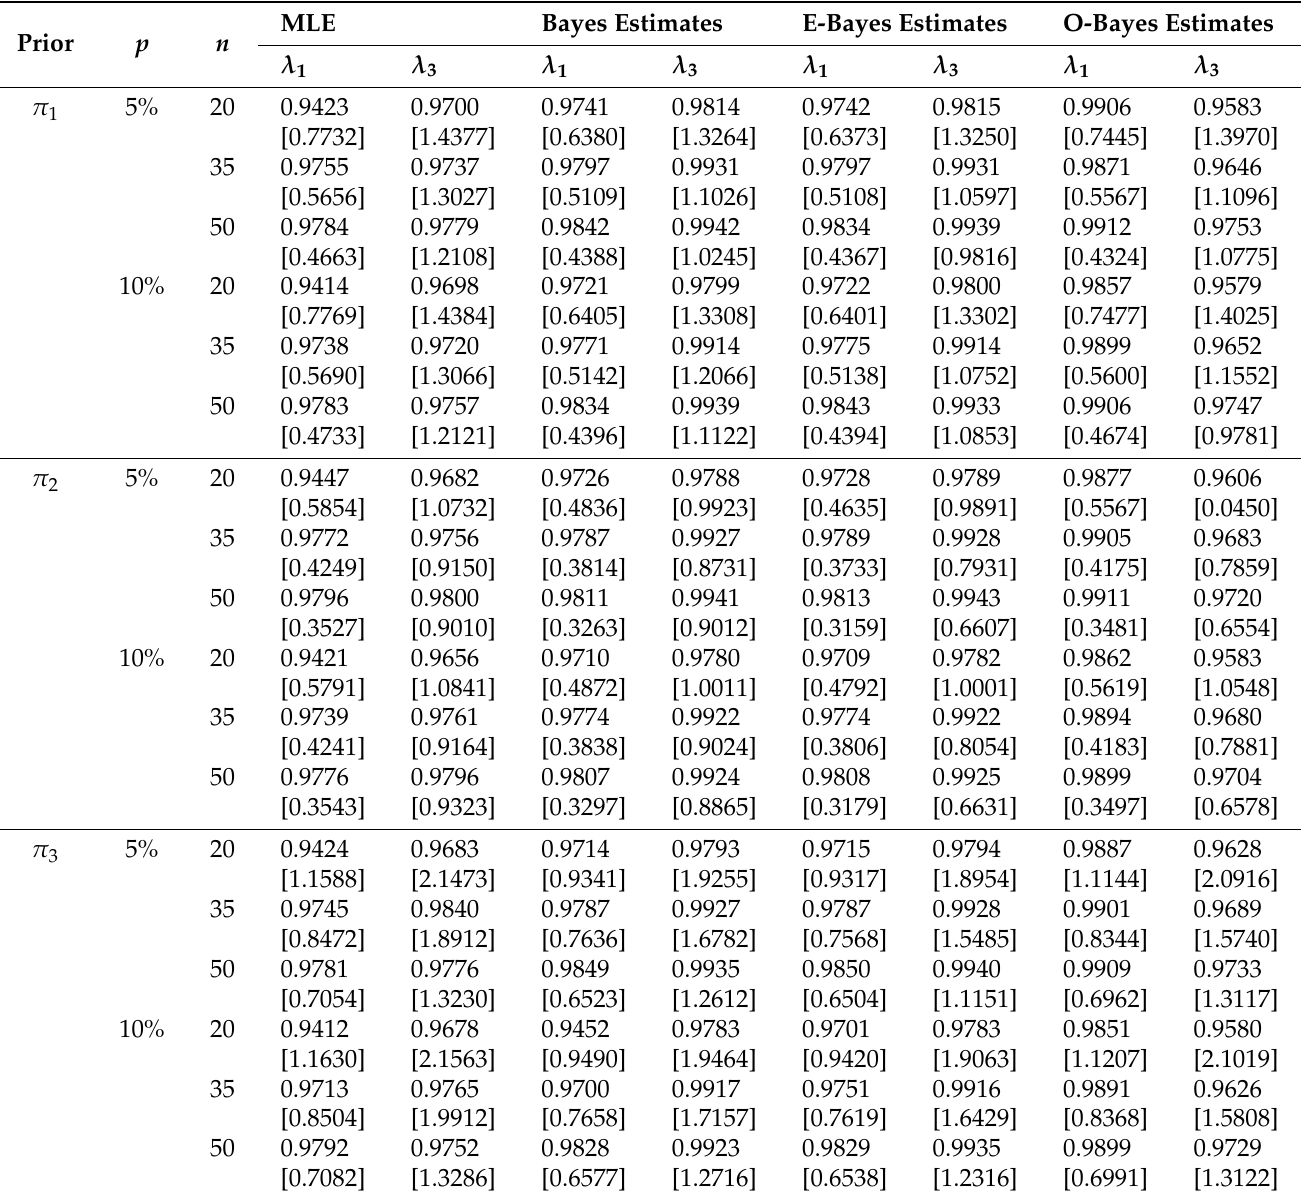
Table 4. CPs and ALs (within bracket) for MOBE competing risks parameters with ( c 1 , c 2 , c 3 ) = ( 3,2.5,1 ) and τ = R